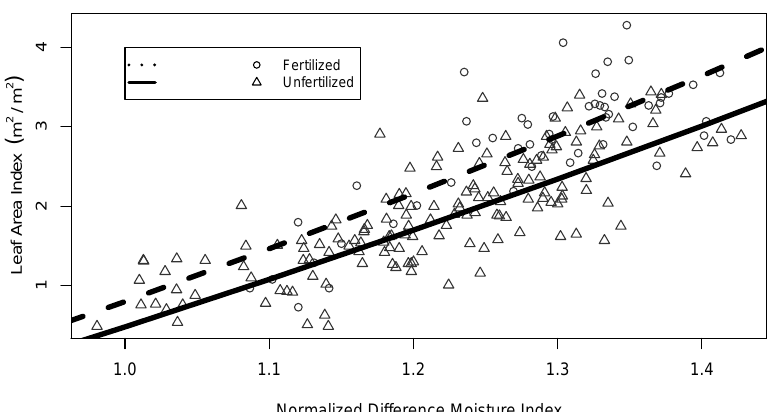
Figure 4. Equation (4) fit using the unbiased parameters estimated using the simulation-extrapolation (SIMEX) methodology. Sites under the optimum nutrition silviculture regime are designated as